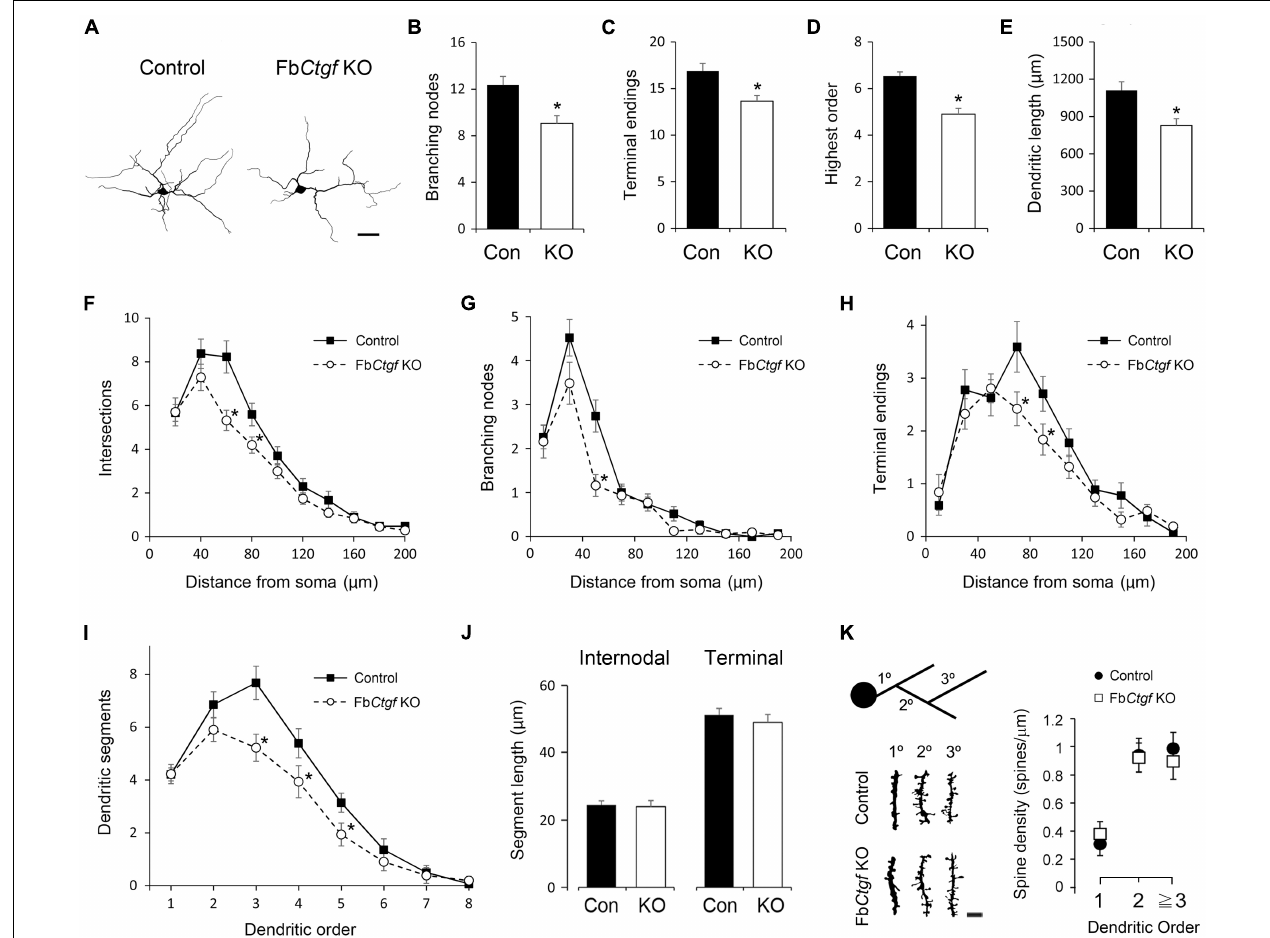
FIGURE 4 | Morphometric analysis of layer VIb neurons in the somatosensory cortex. Golgi-Cox impregnated layer VIb neurons were collected (40 neurons from 6 control mice and 42 neurons from Fb Ctgf KO mice, respectively) and reconstructed. Scale bar is 20 µ m (A) . The dendritic features including the numbers of branching nodes (B) and terminals endings (C) , highest order (D) , and total dendritic length (E) were measured. The complexity and branching pattern of dendrites were estimated using the concentric sphere method (F–H) and the number of dendritic segments (I) . The lengths of intermodal segments and terminal segments were also measured (J) . Dendritic segments of different orders were obtained and the densities of dendritic spines were quantified. Scale bar is 5 µ m (K) . Results are means ± SEM ( ∗ p <